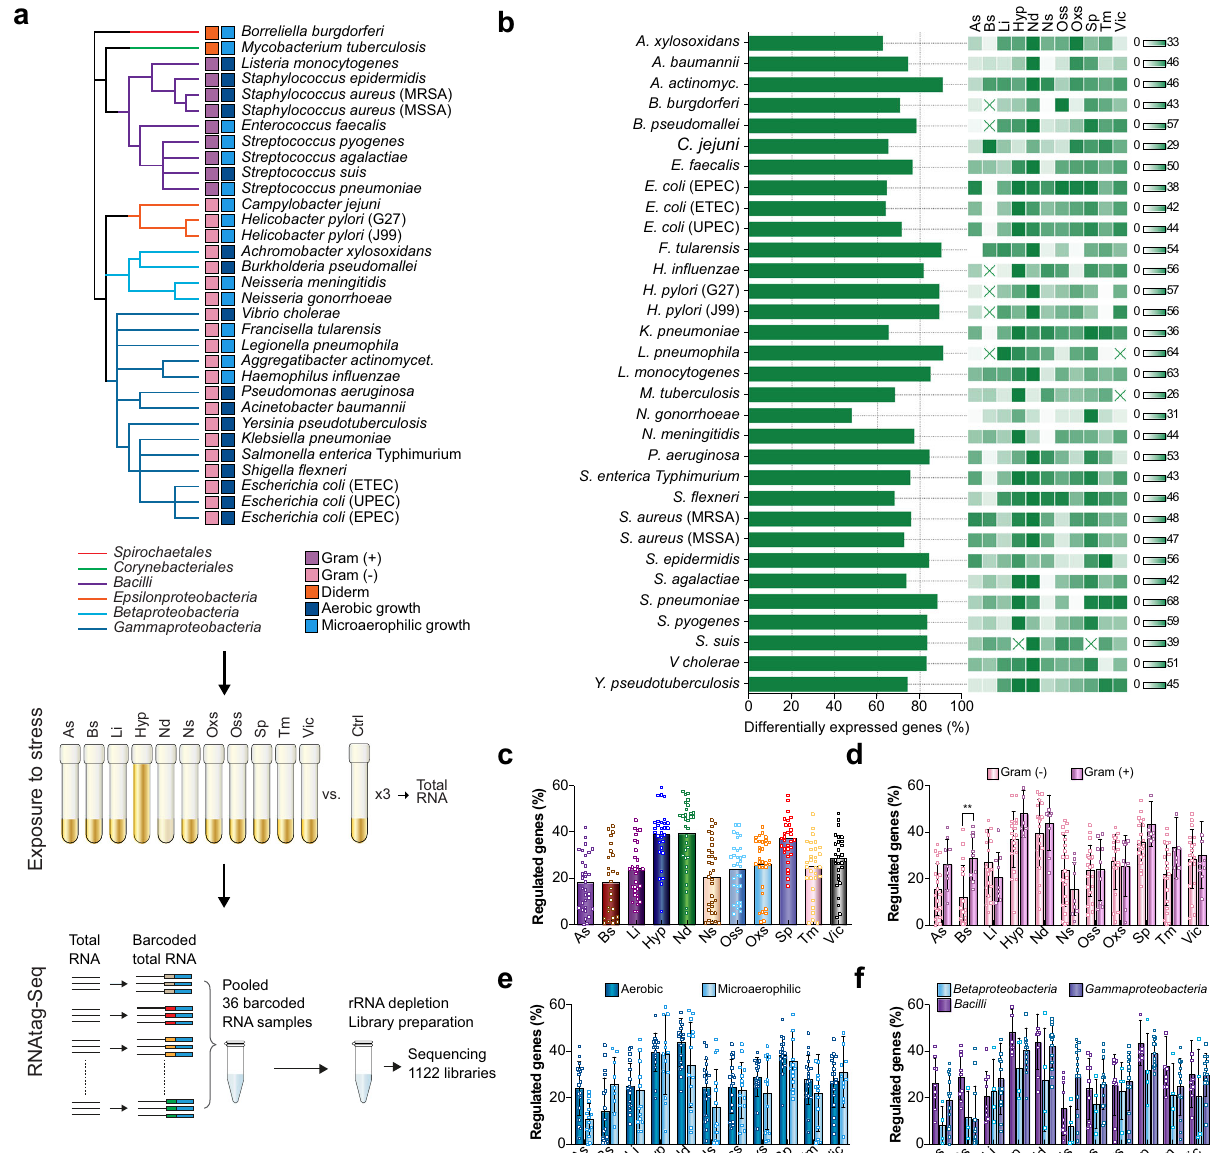
Fig. 1 Stress responses of cross-microbial human pathogens. a Phylogenetic clustering of bacterial species included in the study together with a schematic illustration of the experimental setup for 11 infection-related stress exposures (see also Table 1) and RNA-seq library preparation with RNAtag- Seq allowing multiple samples (36 in this study) per library used for obtaining 1122 transcriptomes deposited in the PATHOgenex RNA atlas. Phylogenetic orders, Gram staining groups, and oxygen dependency are indicated by color. b Proportion of genes differentially regulated in at least one of the conditions for each species. The linked heat maps show proportions of regulated genes for each stress condition. The scales to the right show the span from zero (white) to the highest (green) proportion (%) of regulated genes in the stress condition with the highest percentage of regulated genes. Heat map squares marked with a cross indicate that RNA-seq was not performed for that speci fi c condition. c Dot plot showing the percentages of genes differentially regulated in each condition for all included species, d for Gram-negative and -positive bacteria, e for bacterial groups with aerobic and microaerophilic growth, f for three main phylogenetical orders included in this study. n = 32 species were examined for As, Li, Nd, Ns, Oss, and Oxs; n = 26 were examined for Bs; n = 31 were examined for Hyp; n = 31 were examined for Sp; n = 30 were examined for Vic in c . n = 21 Gram-negative and n = 8 Gram-positive; n = 17 aerobic and n = 15 microaerophilic bacterial species were examined in d and e , respectively. n = 4, n = 14, and n = 8 bacterial species from Betaproteobacteria , Gammaprotobacteria , and Bacilli were examined in e . Data are presented as mean values in c and as mean values ± SD in d , e , and f . The signi fi cance between the groups in d , e , and f was calculated with two-tailed Multiple t-test using Holm-Sidak method by Prism Graphpad version 8.2.0. ** indicates p -value = 0.0033. Source data are provided as a Source Data fi Fig. 3). The bfd gene encoding bacterioferritin ferroxidase, shown upregulated in many of the tested strains under osmotic stress. to be upregulated under iron starvation 23,24 , was upregulated Further, dps encoding DNA protection during starvation protein, under low iron condition in all strains harboring the gene. shown to be positively regulated in an RpoS-dependent manner Similarly, proW encoding a permease that is part of the during stationary phase 26 , was upregulated in many strains osmotically inducible ProU ABC transporter system 25 , was during stationary phase. The observed downregulation in E. coli